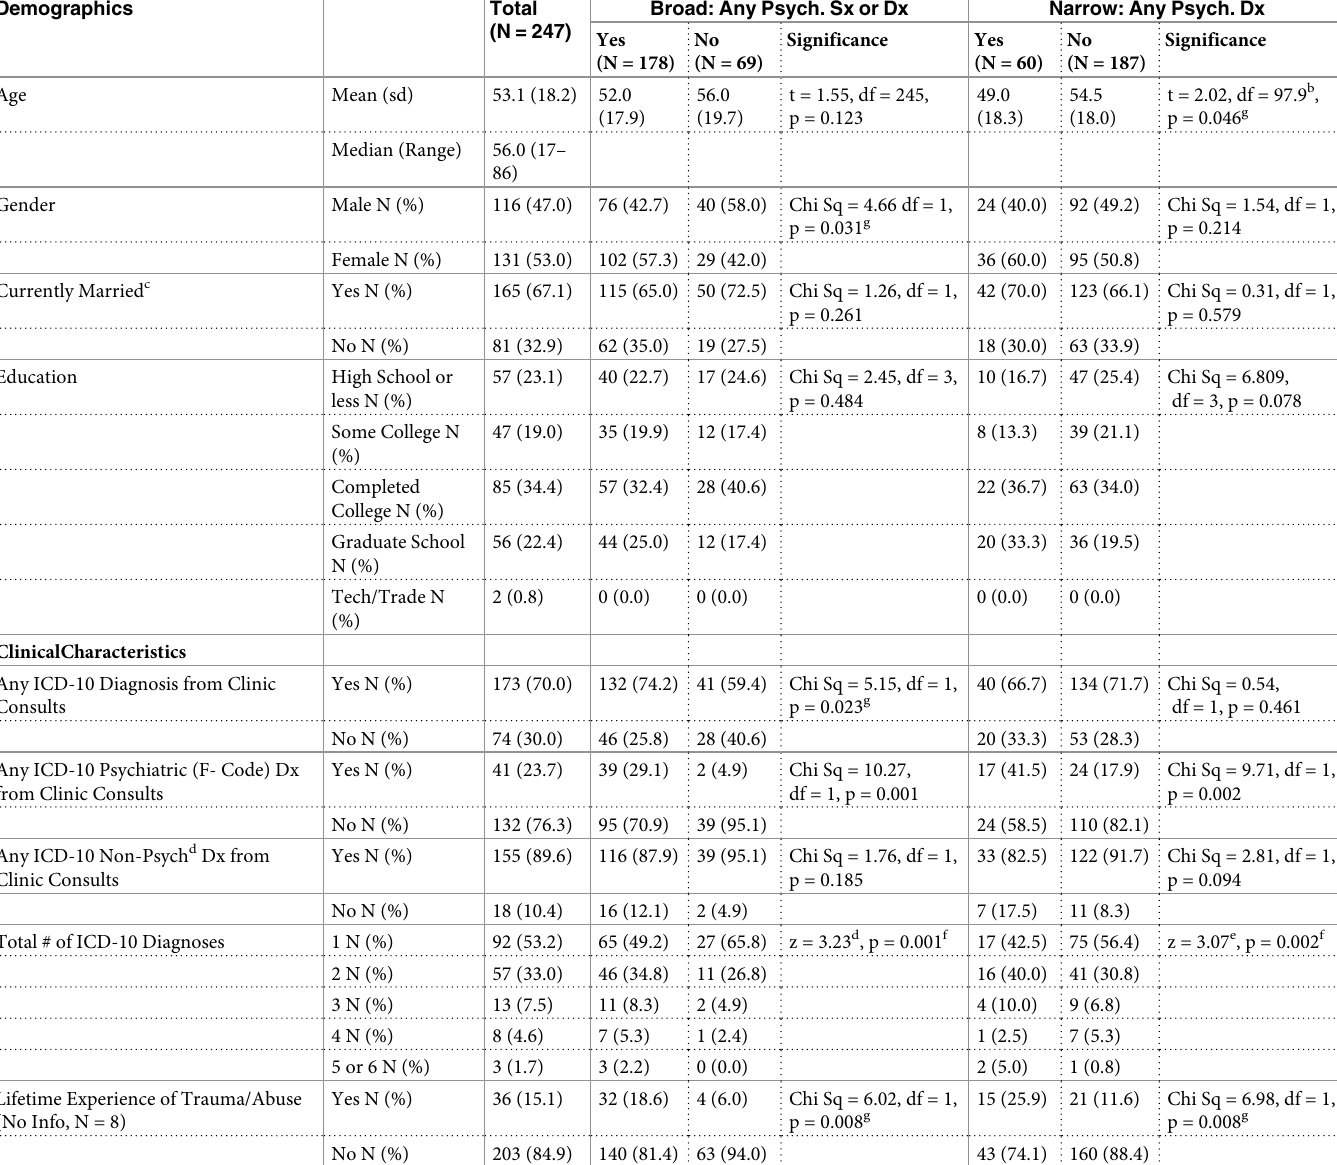
Table 1. Demographic and clinical characteristics of the emory special diagnostic services (ESDS) sample (N = 247). Overall Sample and By Broad and Narrow Defi- nitions of Psychiatric Complaints at Intake a